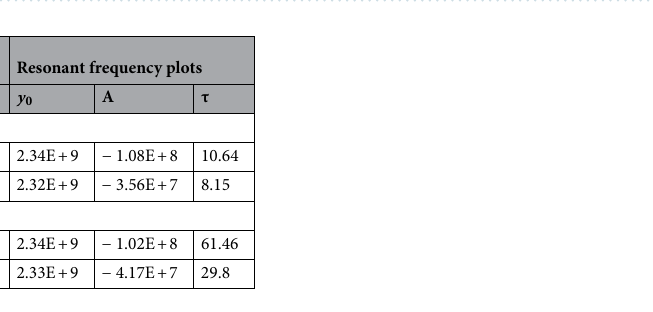
Figure 11. ( a ) Resonant amplitude and ( b ) resonant frequency recorded during the ice thickness experiments, and ( c ) the pictured droplet holder on the antenna with water and ice. Within the plots, the dotted red line is an exponential curve fit and the bold red line is the time averaged data range.